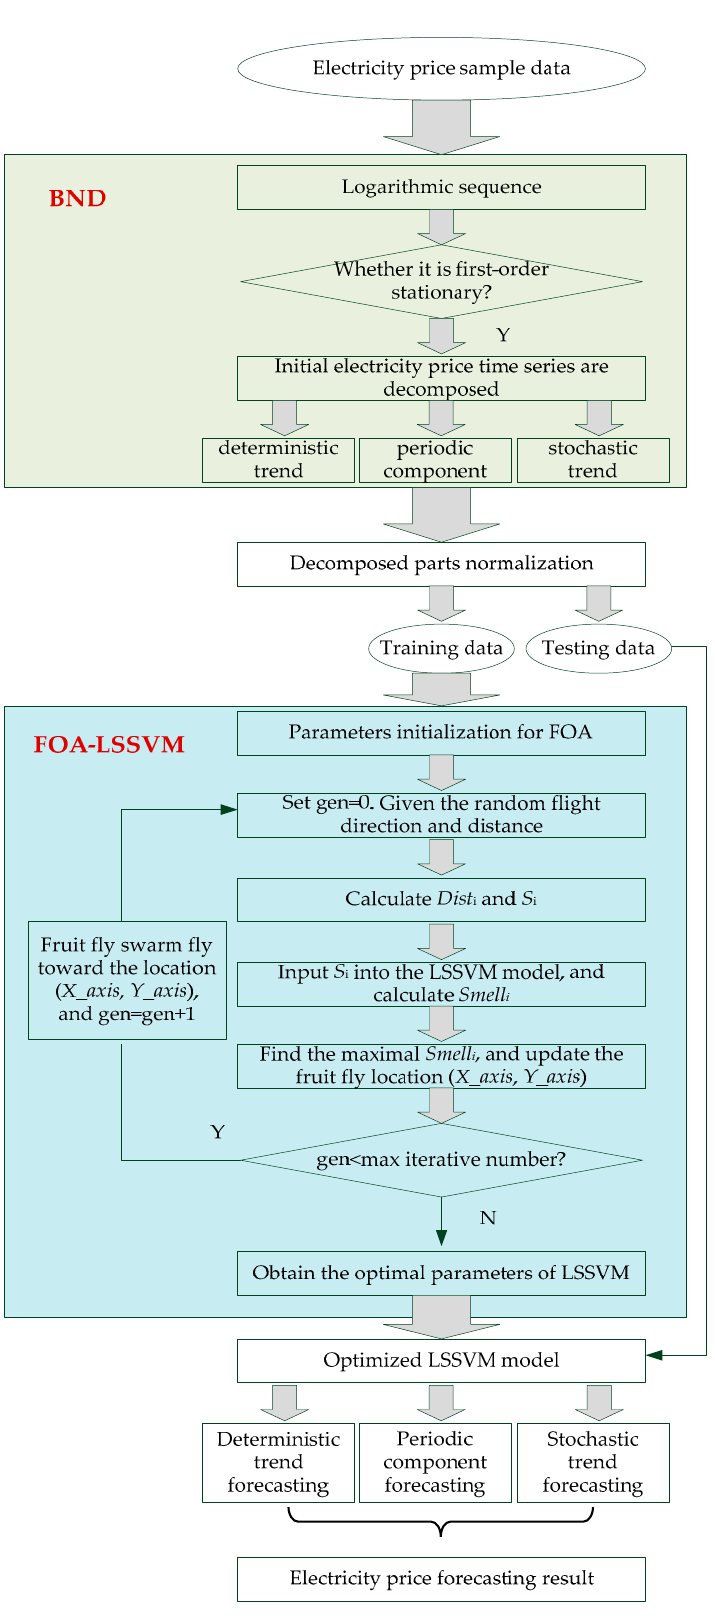
Figure 1. Flowchart of the proposed Beveridge-Nelson decomposition (BND)-fruit fly optimization algorithm (FOA)-least square support vector machine (LSSVM) model for electricity price forecasting.